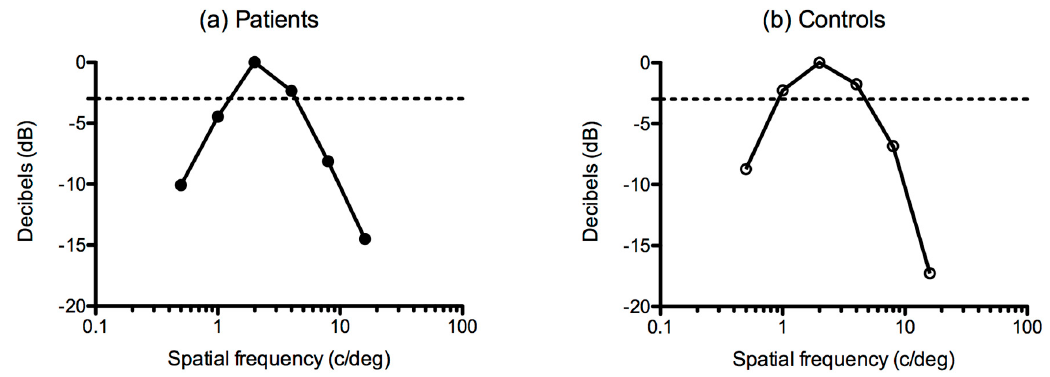
Figure 2. Relative sensitivity (dB) for ( a ) the myalgic encephalomyelitis (ME) group and ( b ) controls derived from Equation (1). Analysis was performed separately on the mean contrast sensitivity data for each group. Dashed lines represent—3 decibels from peak sensitivity (at which sensitivity drops to half its maximal power).